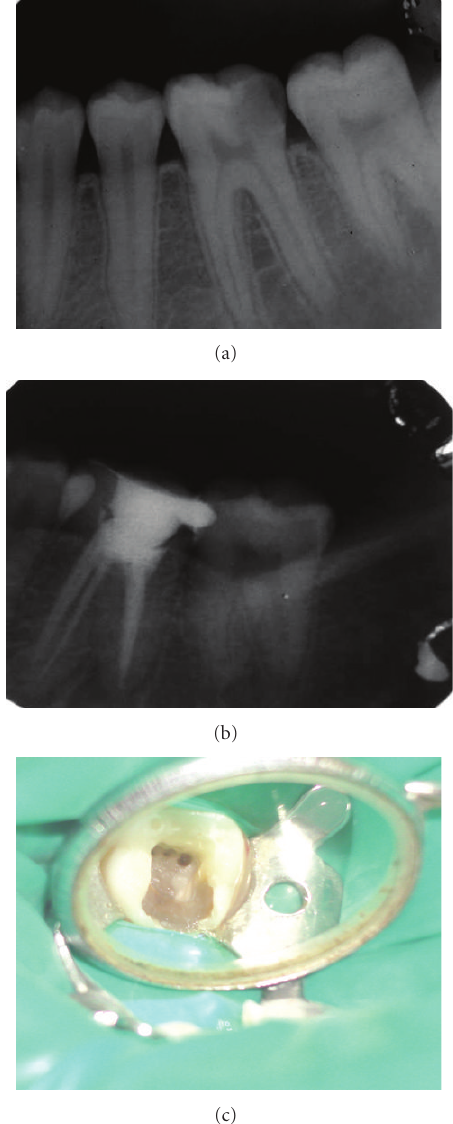
Figure 2: (a) Preoperative radiograph. (b) Obturation. (c) Clinical